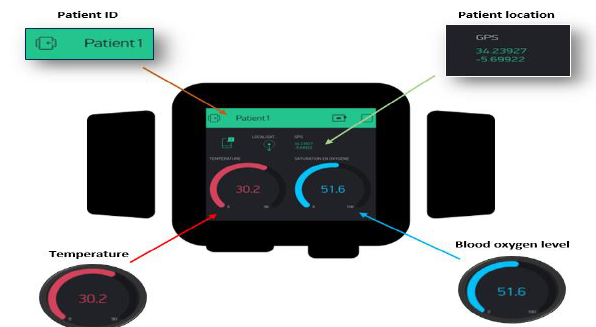
Figure 7 : Covid-19 smart